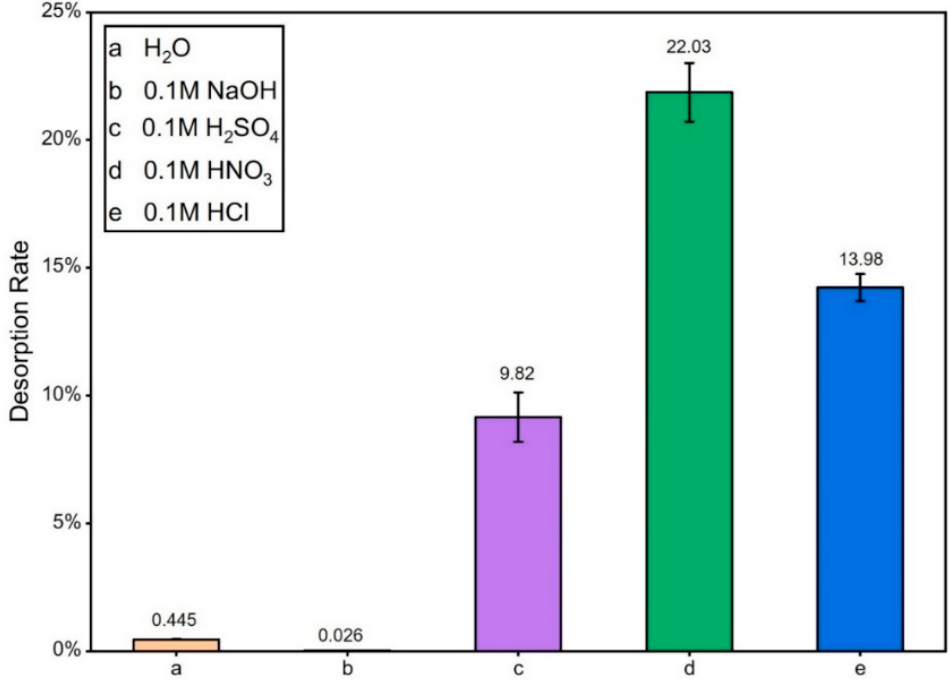
Figure 18. Desorption rate of MCS3 ‐ 1.